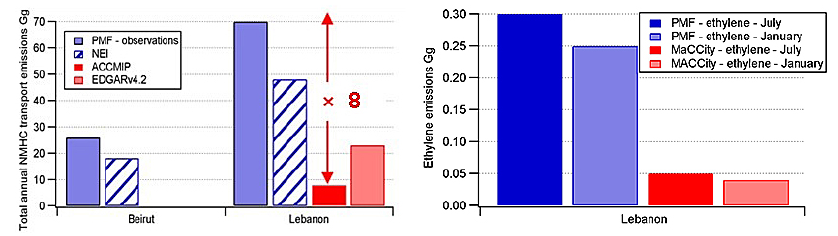
Figure 12. Comparison of the PMF results and emission inventories (national and global) for the transport sector emissions.